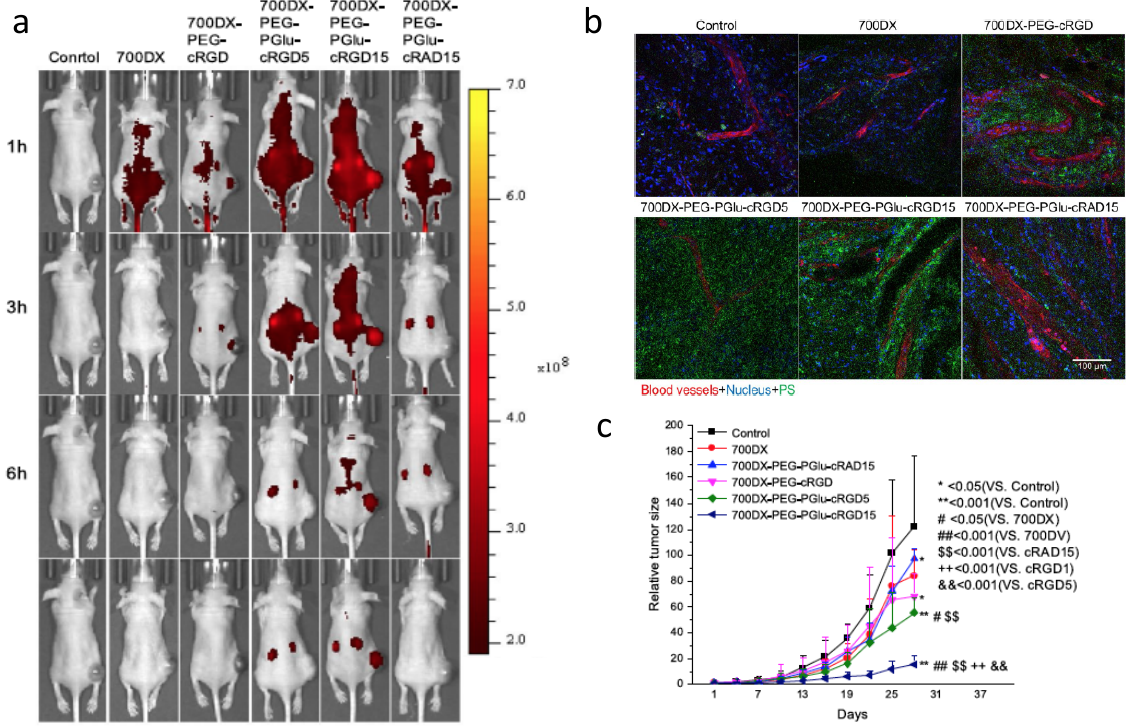
Figure 7. ( a ) Fluorescence images of mice bearing U87MG tumors after injected with arginine-glycine-aspartate peptide (RGD) modified IR700-polymers. ( b ) Confocal images showing intratumor distribution of photosensitizers. ( c ) In vivo PDT of mice bearing U87MG. Reprinted with permission from Ref. [137]. Copyright 2018 Springer Nature.